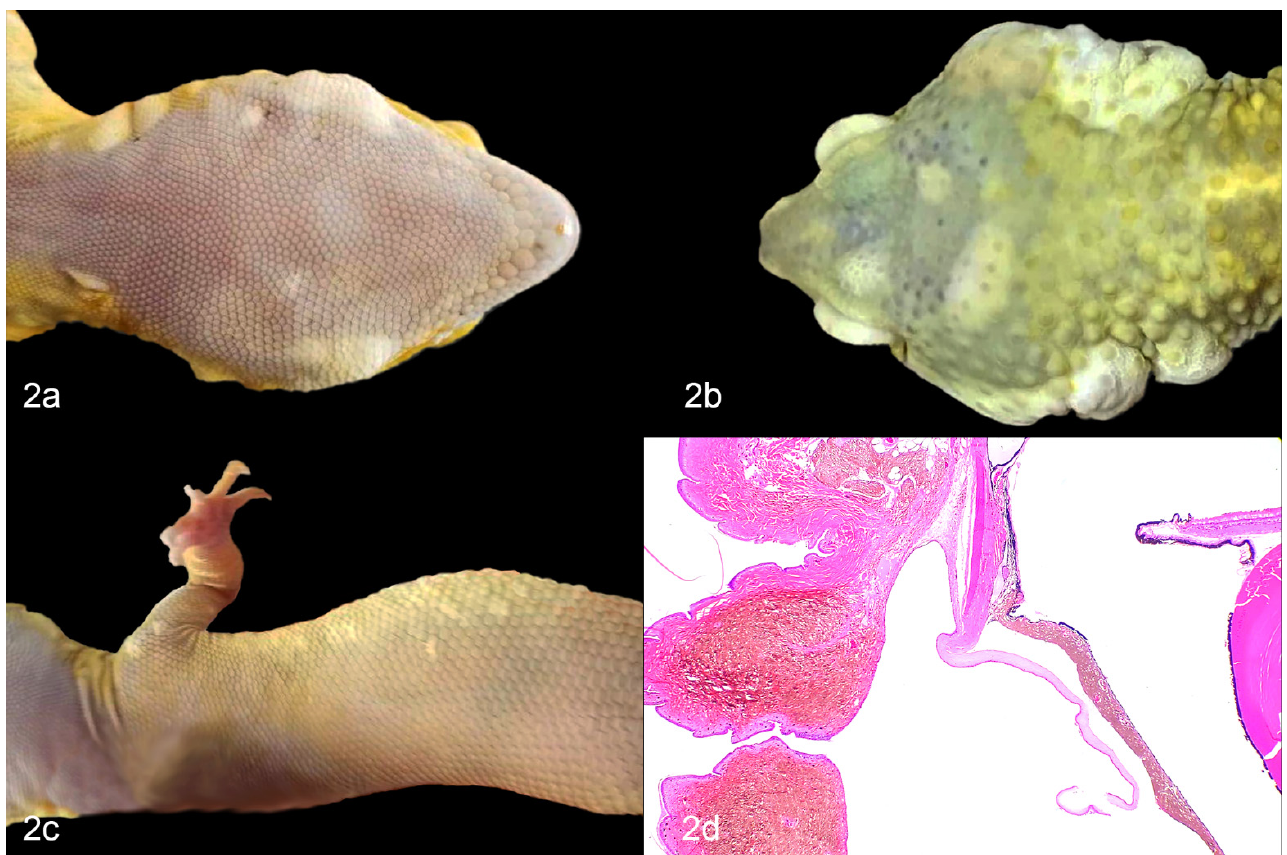
Figure 2. Iridophoromas in ‘lemon frost’ leopard geckos ( Eublepharis macularius ). ( a ) Multiple white, nodular, cutaneous iridophoromas along the ventral mandible. ( b ) Multiple white, smooth to nodular, cutaneous iridophoromas on the dorsal aspect of the head and bilaterally within the periaural skin. ( c ) Multiple, pale yellow, smooth, pigmented scales of a cutaneous iridophoroma. ( d ) Iridophoroma in the iris, conjunctiva, periocular skin, and connective tissues. H&E.